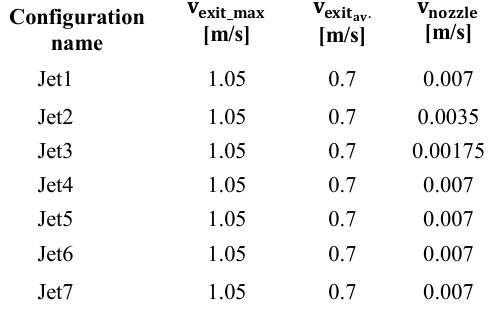
Table 2. Double slot jet configurations – parameters of the flow Configuration